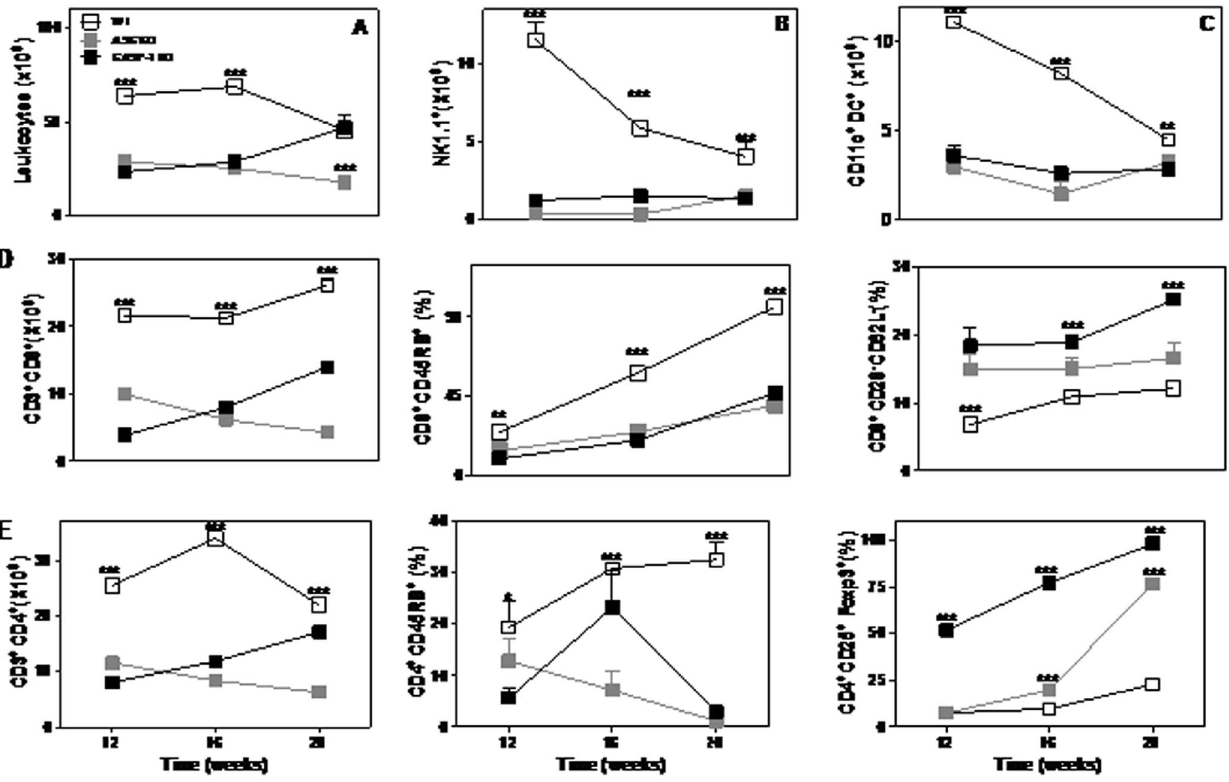
Figure 4. Characterization of leukocyte populations in the lymph nodes with SCC in the absence of inflammasome. The absolute number of leukocytes (A), DC (B), NK (C) CD3 + CD8 + (D), CD3 + CD4 + (E) cells in the lymph nodes was determined by flow cytometry. The proportion of and were determined in samples from ASC-KO (gray square), CASP-1-KO (black square) and WT (white square). Values are mean 6 SEM; *** p # 0.001 compared with WT